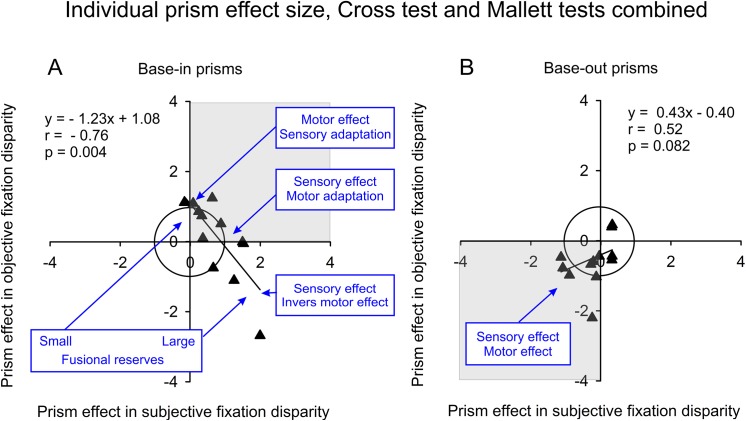
Interpretation of the relation between individual prism effects sizes of subjective versus objective fixation disparity, i.e. di(sFD) versus di(oFD).The combined data of the Cross test and the Mallett tests are presented separately for base-in and base-out prisms. The grey quadrants indicate where individual data points are expected based on the hypotheses, that shifts should be in the positive (eso) direction with base-in prisms and in the negative (exo) direction with base-out prisms. The inner circle has a radius of 1.0 and indicates that individual data points near or outside the circle are statistically large. The regression equations, correlation coefficients and two-tailed p-values are based on robust statistical procedures (n = 12). The blue insets describe the working hypothesis of the underlying physiological mechanisms (see Discussion).